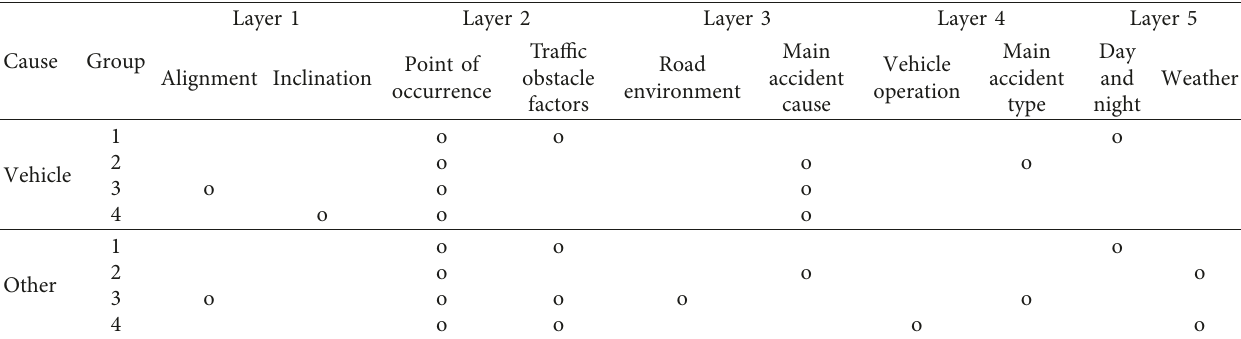
Table 13: Top three topic distribution by group.